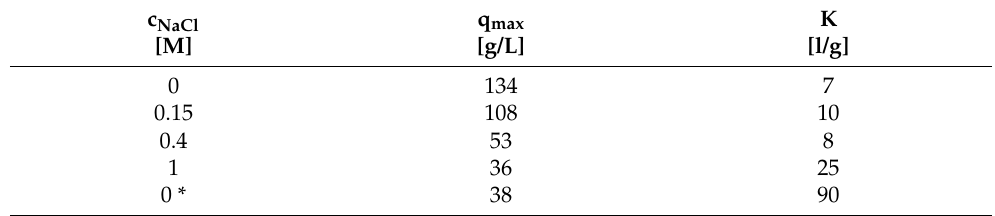
Figure 7. Adsorption isotherms of BSA ( A ) and DNA ( B ) on Sartobind STIC at different NaCl concentrations: ( • ) 0 M, ( ▲ ) 0.15 M ( ■ ) 0.4 M, and ( 🞨 ) 1 M. Lines represent Langmuir adsorption isotherm approximations. Table 1. Parameters of the Langmuir isotherm for the equilibrium data presented in Figure 7.